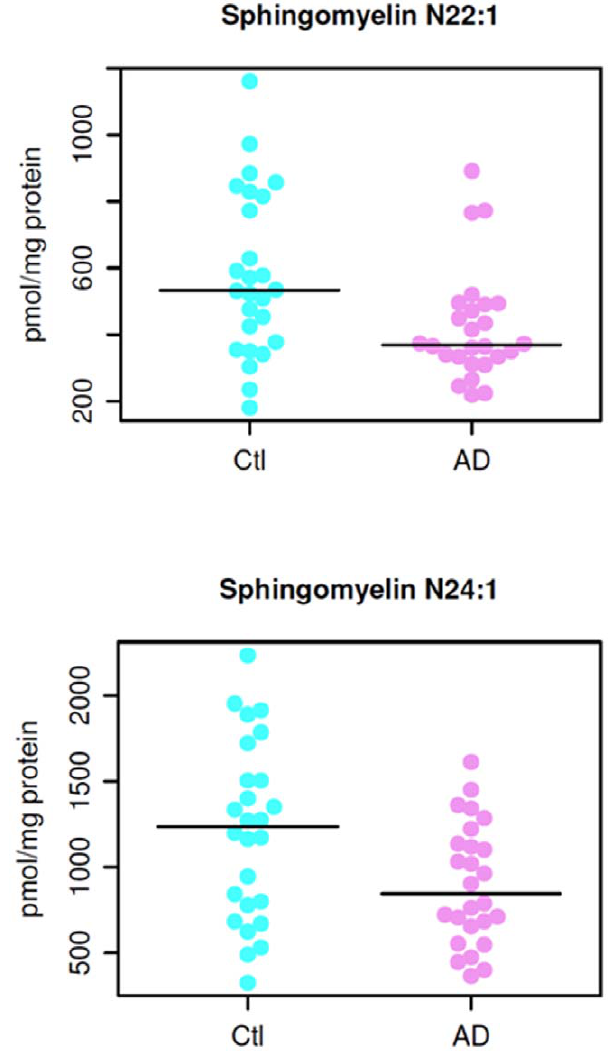
Figure 3. Mass levels of N22:1 (panel A) and N24:1 (panel B) sphingomyelin species in AD and healthy controls.